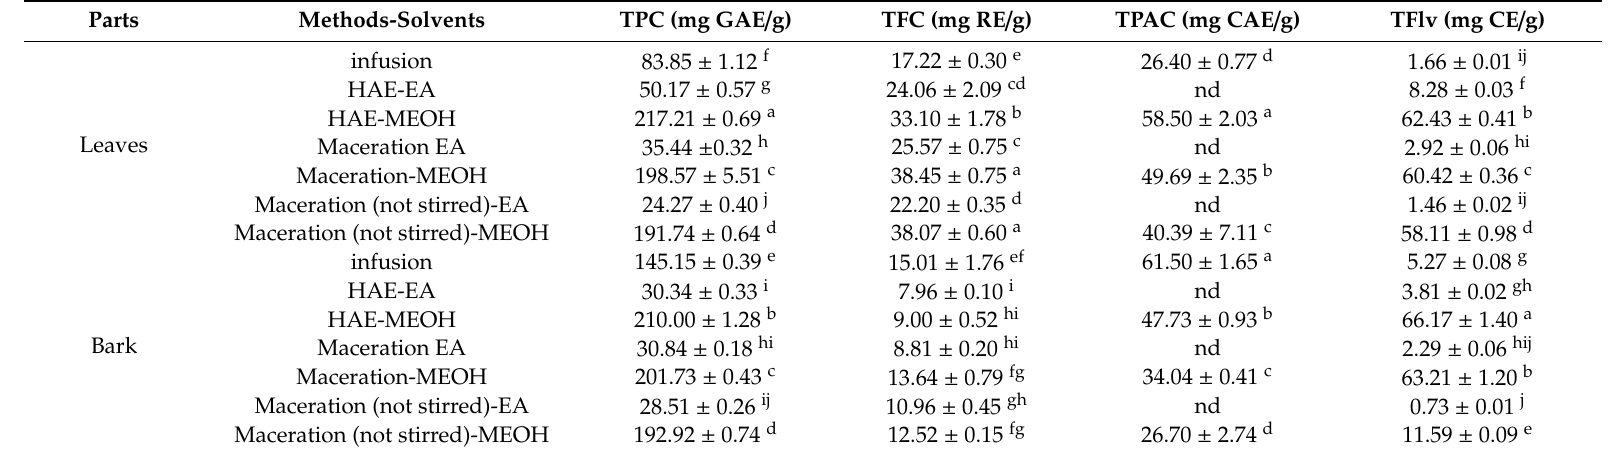
Table 1. Total bioactive compounds (phenolic (TPC), flavonoid (TFC), phenolic acid (TPAC) and flavonol (TFlv) of the tested extracts